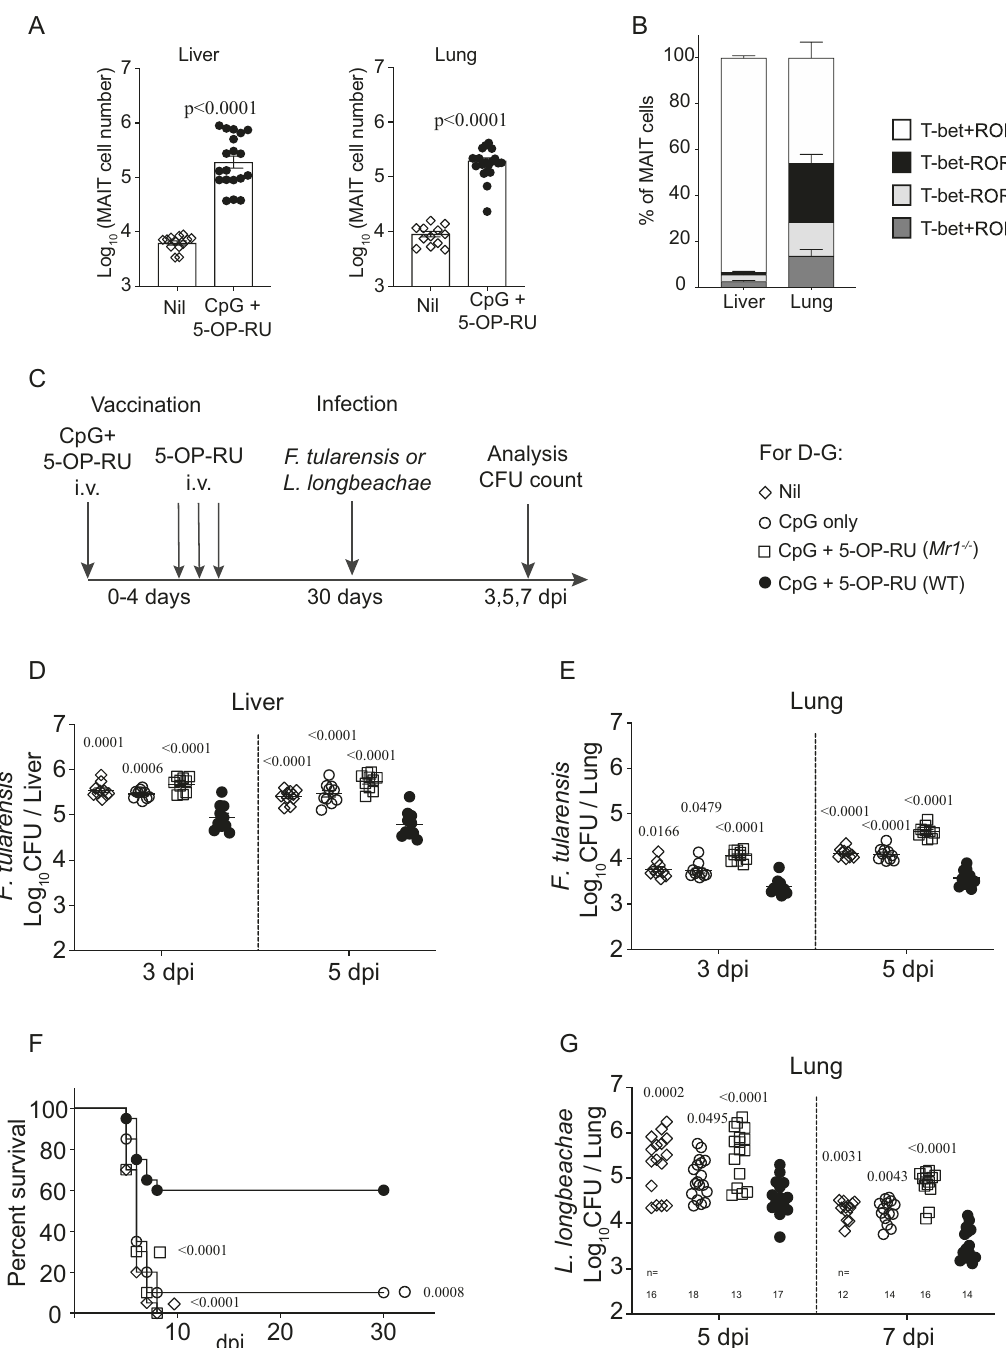
Fig. 8 MAIT cell-targeted vaccination delivers signi fi cant protection against both local and systemic bacterial pathogens. A MAIT cell number, and B T-bet and ROR γ t phenotype of MAIT cells in the liver and lungs of C57BL/6 mice 30 days after i.v. vaccination with 5-OP-RU and CpG (as depicted in C ). Pooled data from three independent experiments with similar results (mean ± SEM. A : n = 13 (unvaccinated) or 19 (CpG + 5-OP-RU) mice per group, B : n = 9 mice per group). Unpaired t -test (two-tailed), P -values are indicated. C Schematic fl ow chart for vaccination and challenge. Mice were administered with CpG (10 nmol) alone or CpG together with 2 nmol 5-OP-RU in 200 μ l PBS at day 0) and 5-OP-RU (2 nmol in 200 μ l PBS on day 1, 2, and 4). After 30 days, mice were infected with 2.5 × 10 4 CFU of F. tularensis LVS i.v. or 10 4 CFU of L. longbeachae i.n. D , E Bacterial load in the liver and lungs, respectively, of unvaccinated WT (C57BL/6) mice (Nil, open diamond), mock-vaccinated WT mice (CpG-only, open circle), vaccinated Mr1 − / − mice (CpG + 5-OP-RU, open square), and vaccinated WT mice (CpG + 5-OP-RU, fi lled circle) at indicated time points post F. tularensis challenge (2.5 × 10 4 CFU, i.v.). F Survival of mice vaccinated (as in D – F ) after F. tularensis challenge (3 × 10 4 CFU, i.v.). G Bacterial load in lungs of mice vaccinated and challenged with L. longbeachae at indicated time points post L. longbeachae challenge. One-way ANOVA on log-transformed data (unvaccinated, CpG-only, and vaccinated Mr1 − / − groups were compared with vaccinated WT group). P -values are indicated. Pooled data from three independent experiments with similar results (mean ± SEM, n = 10 ( D , E ), 20 ( F ), or 12 – 18, as indicated ( G ) mice per group). Source data are provided as a Source Data fi